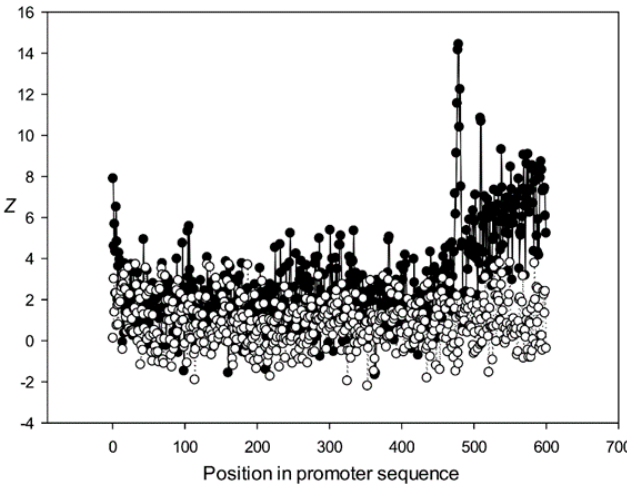
Figure 13. Dependence of Z on position l for promoter sequences of the fifth class. Black circles indicate multiple alignment for promoter sequences of the fifth class and white circles indicate randomly mixed promoter sequences where positions of indels were maintained.